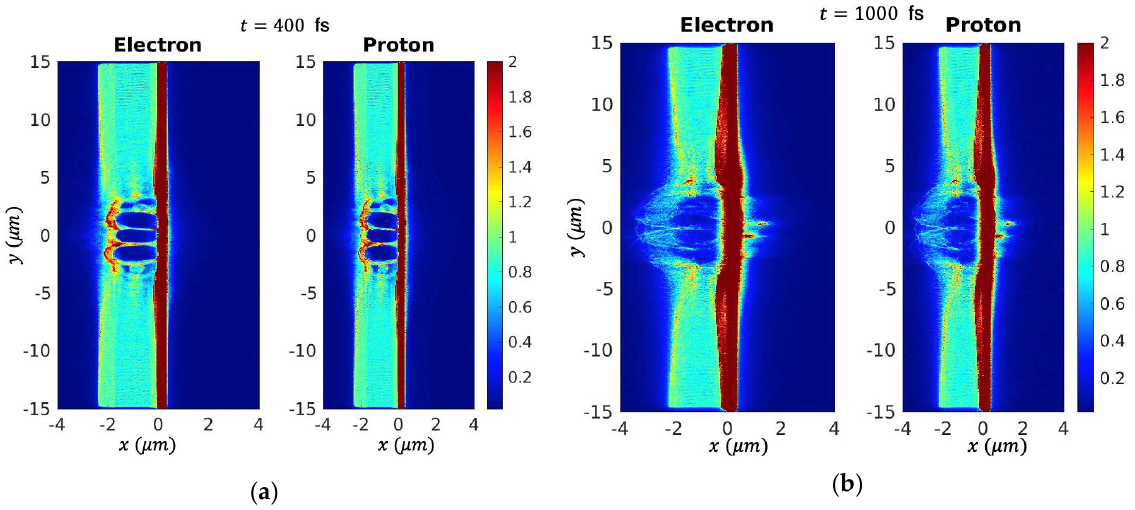
Figure 9. Evolution of electron and proton density at 400 fs and 1000 fs respectively for 2D simulation. Highly organized vortices emerge from the non-linear interaction of the laser pulse with the near critical foil ( a ). As in the 1D simulation, the vortices are maintained for extended period of time ( b ) compared to the case of laser foil-only.